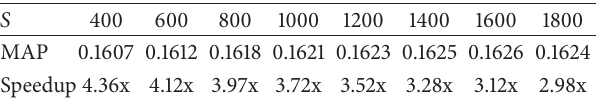
Table 2: MAP and speedup variations with S on Corel 10 K ( 𝐻 = 3, 𝑇 = 500 ). 𝑆